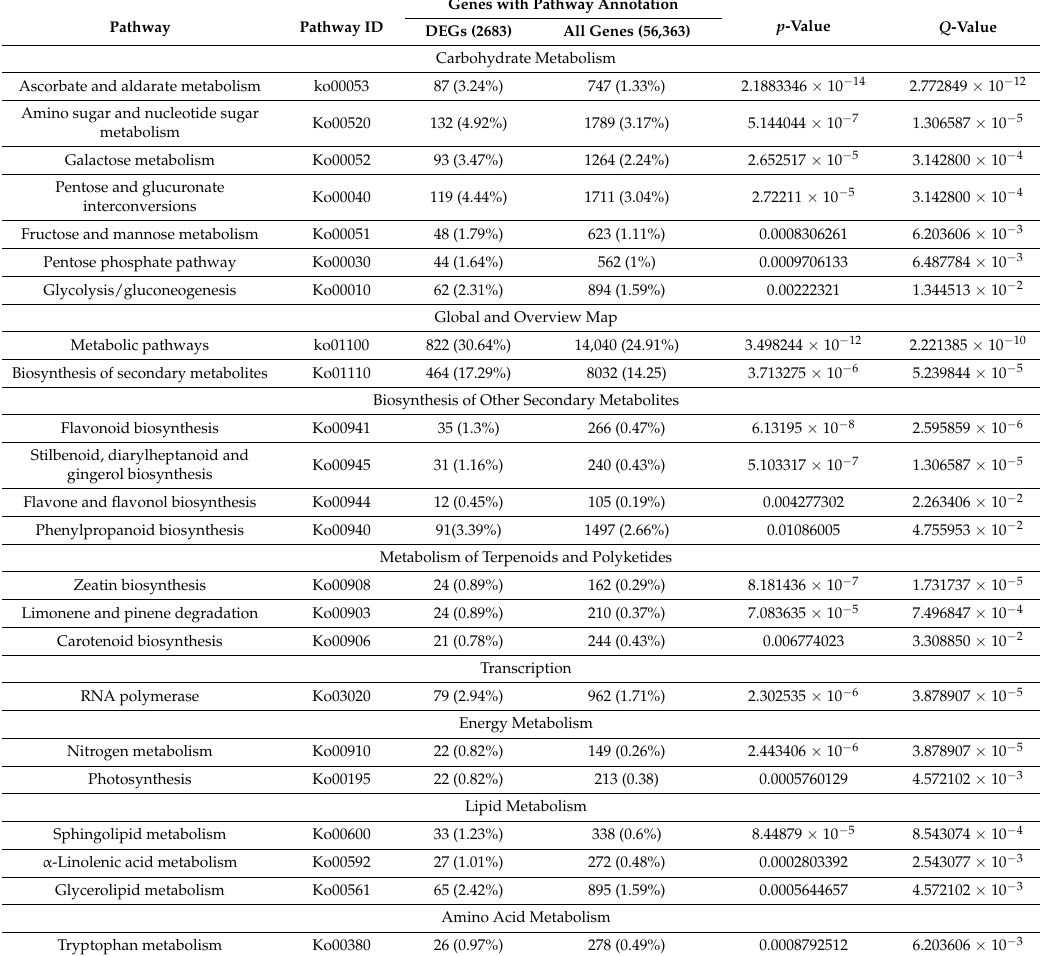
Table 2. Statistical enrichment analysis of Kyoto Encyclopedia of Genes and Genomes (KEGG) metabolic pathways ( p ≤ 0.05, Q ≤